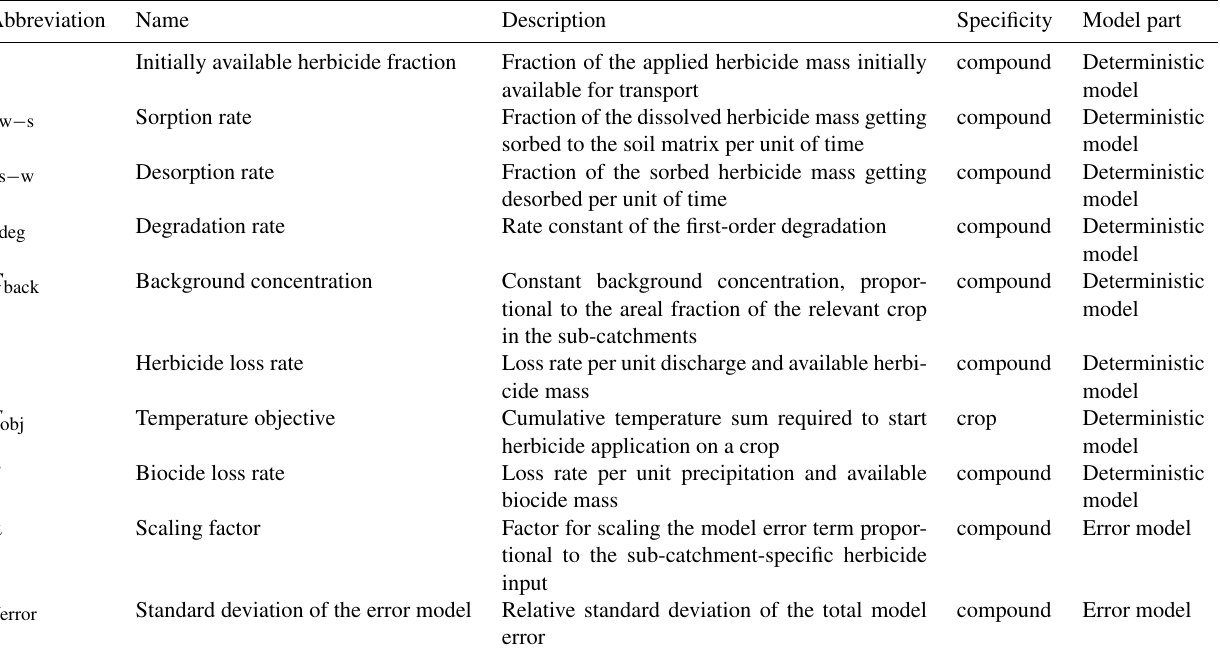
Table 1. Global model